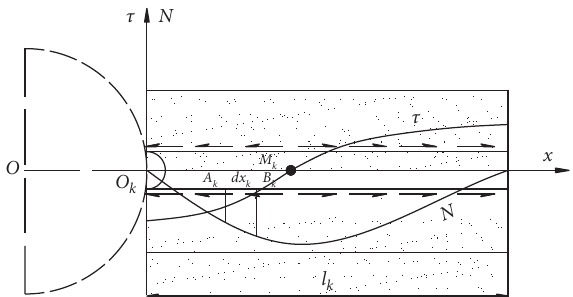
Figure 11: Computational model of the zonal thickness of sur- rounding